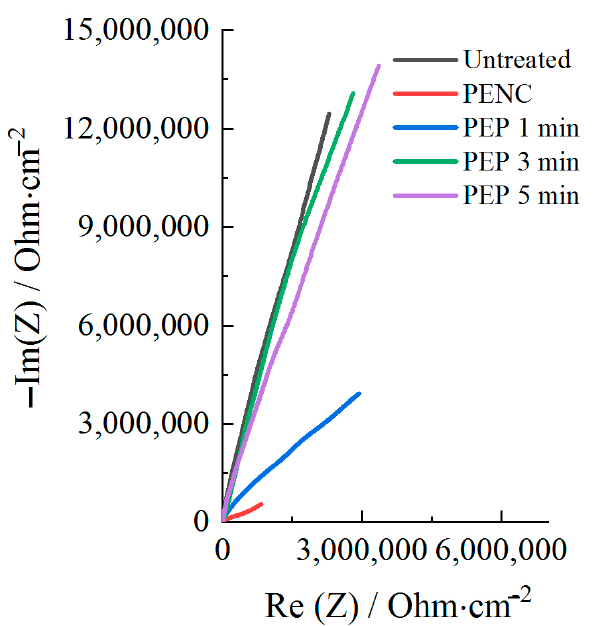
Figure 10. Nyquist plots of the CP-Ti samples before and after anodic PENC at 900 ◦ C and subsequent PEP in a solution of ammonium fluoride (4%) at 300 V for different time.